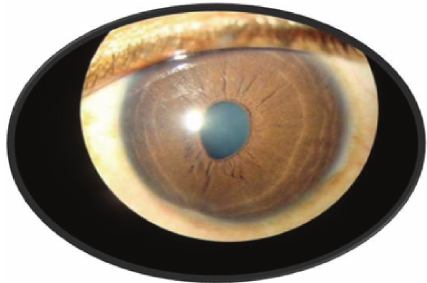
Figure 5: UBM picture showing near total resolution of the mass at 6